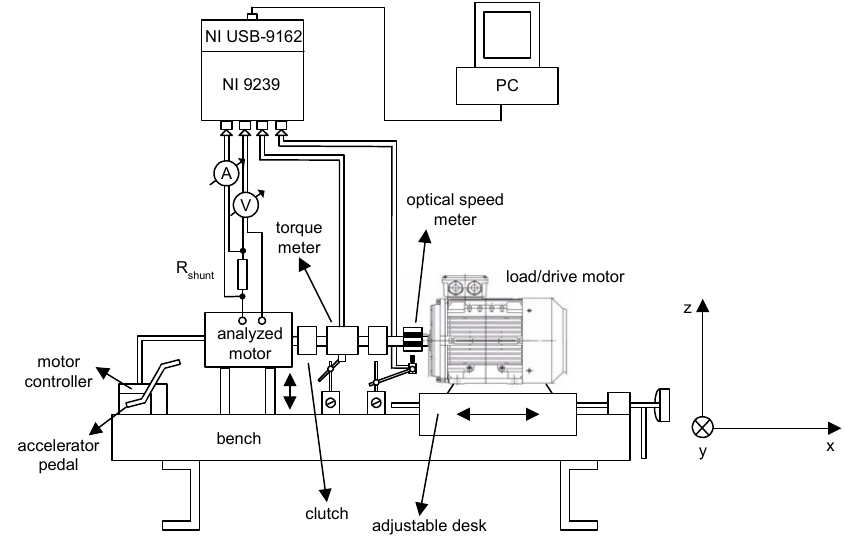
Figure 2. The schematic diagram of the test bench.